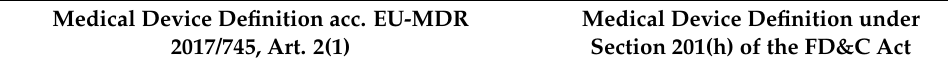
Table 2. Comparison of EU-MDR and FD&C Act definitions of medical